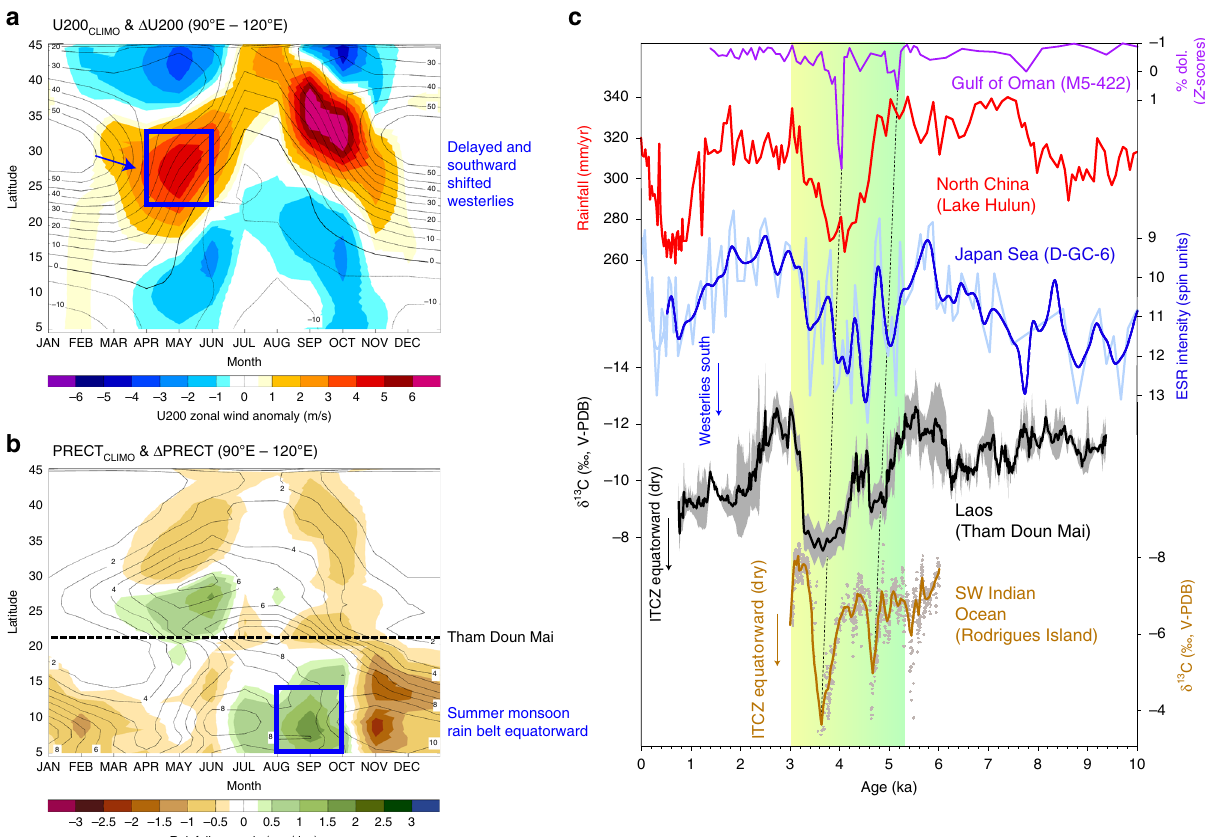
Fig. 6 Seasonal shifts in the westerlies and precipitation across East Asia between dry and wet Sahara. a , b Hovmöller diagrams of climatological U200 winds and precipitation for wet Sahara and its anomalies (contours: MH GS + RD climatology; shading: difference between MH PMIP and MH GS + RD experiments). c Support for the model simulations is provided by the paleoclimate archives, which show drier conditions in North China (red) 76 due to a southward shift in the westerlies (blue; inferred from ESR intensity of silt-sized quartz grains in sediments from the Japan Sea) 61 and equatorward contraction of the ITCZ during boreal summer (black; this study) and austral summer (brown) 77 . Vertical color bar indicates the transition from a wet to a dry Sahara between 5.5 and 3.5 ka 2,3